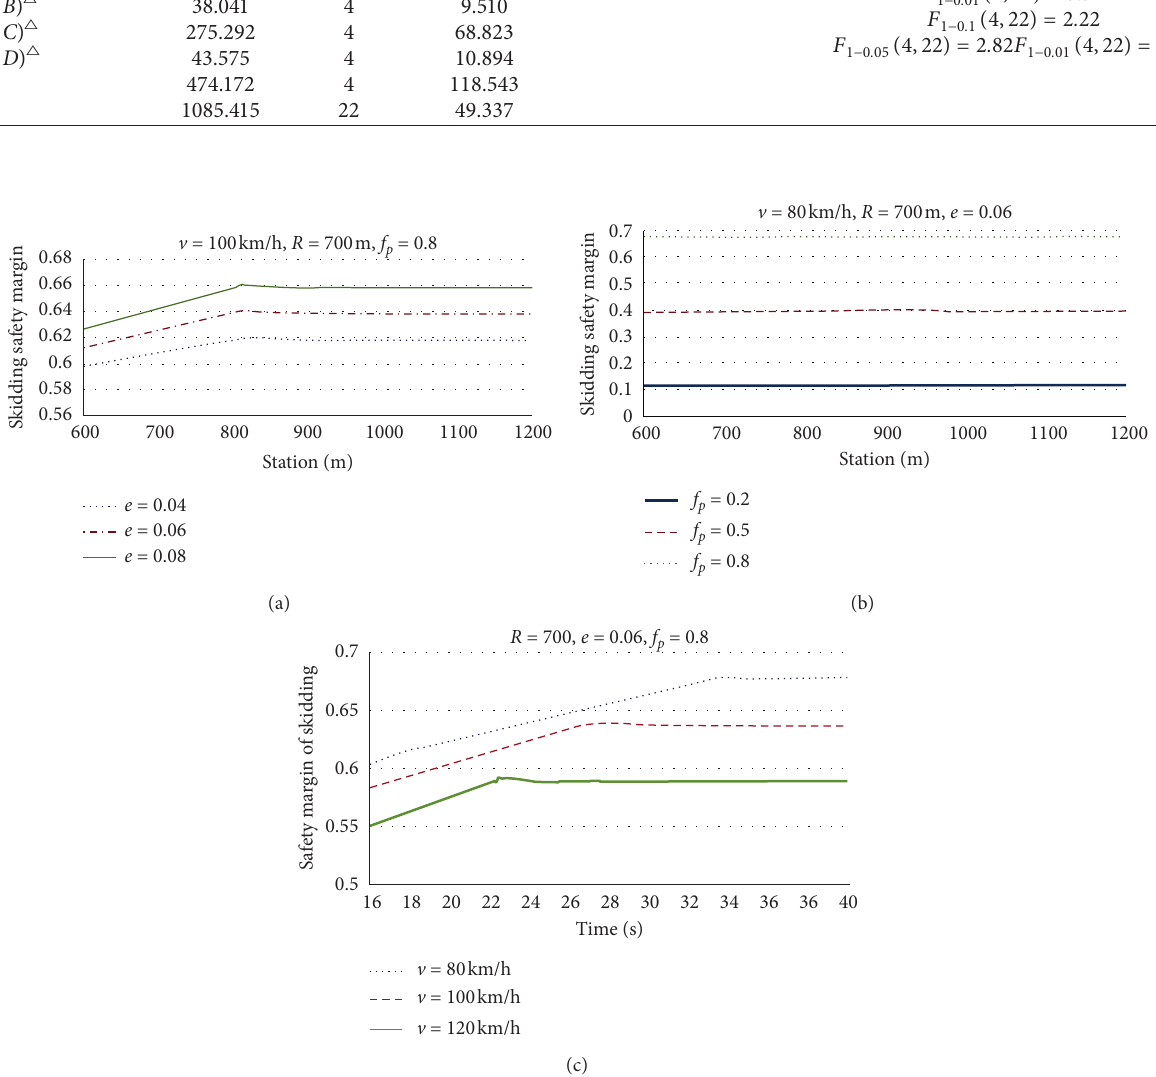
Figure 7: The effect of the significant single factor on the safety margin of the vehicle’s skidding. (a) Effect of superelevation on the safety margin of skidding. (b) Effect of the pavement friction coefficient on the safety margin of skidding. (c) Effect of speed on the safety margin of